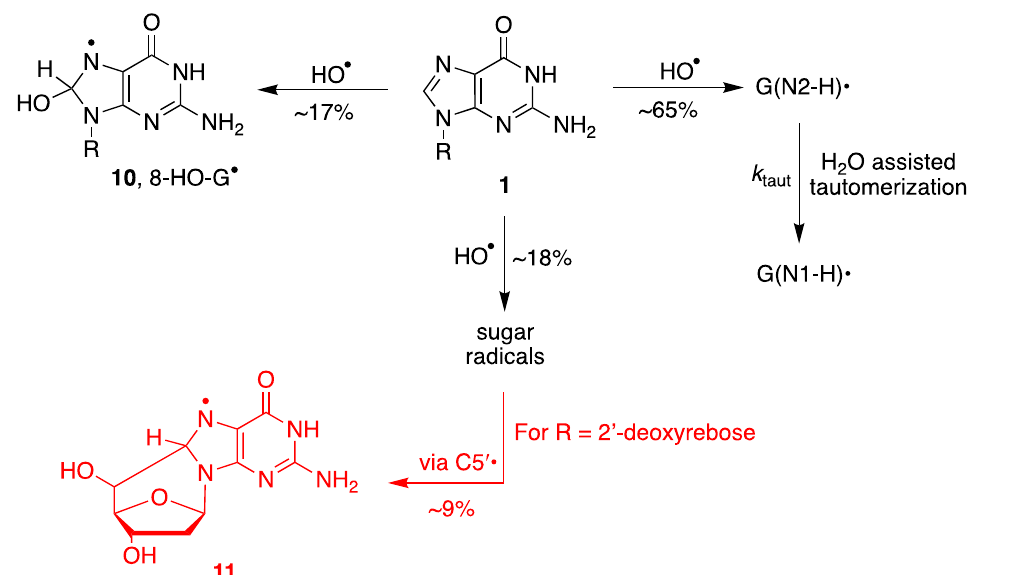
Figure 6. Reaction of HO • with guanine moiety of 1 in aqueous medium. The main path (~65%) is the H-atom abstraction from the exocyclic NH 2 group to give G(N2-H) • followed by water-assisted tautomerization G(N1-H) • . The two minor paths are the addition at the C8 position giving the adduct 10 (~17%) and the hydrogen abstraction from the sugar moiety (~18%). When R = 2 ′ -deoxyrebose, about half of the H-atom abstraction from the sugar occurs at the H5 ′ positions, followed by cyclization with the formation of radical 11 (adapted from [33]).